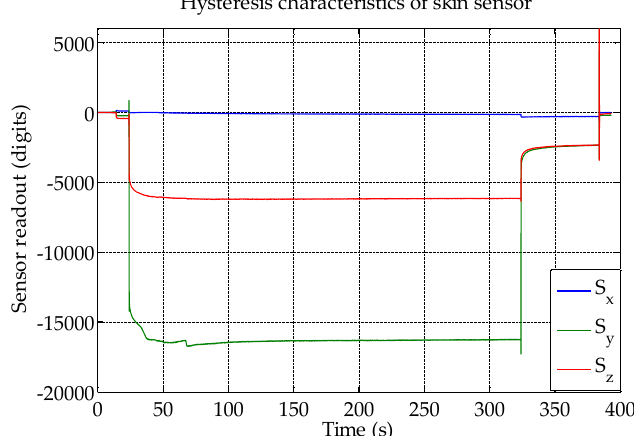
Figure 6. Hysteresis characteristics of the skin sensor.